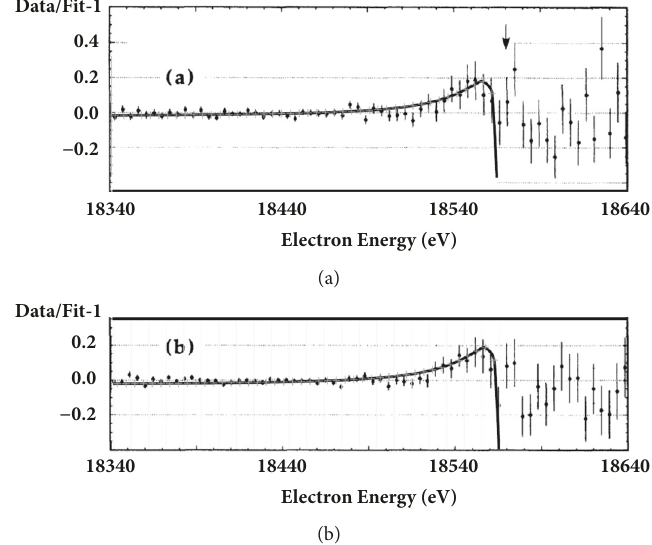
Figure 6: The published data for the Livermore Collaboration shown as residuals to a fit to the spectrum assuming zero effective mass, taken from [19]. The curve added by the author shows what the residual graph would look like assuming the true spectrum was described by the 3 + 3 model masses. (a) and (b) are for two subsamples of the data, and the arrow shows the spectrum endpoint.